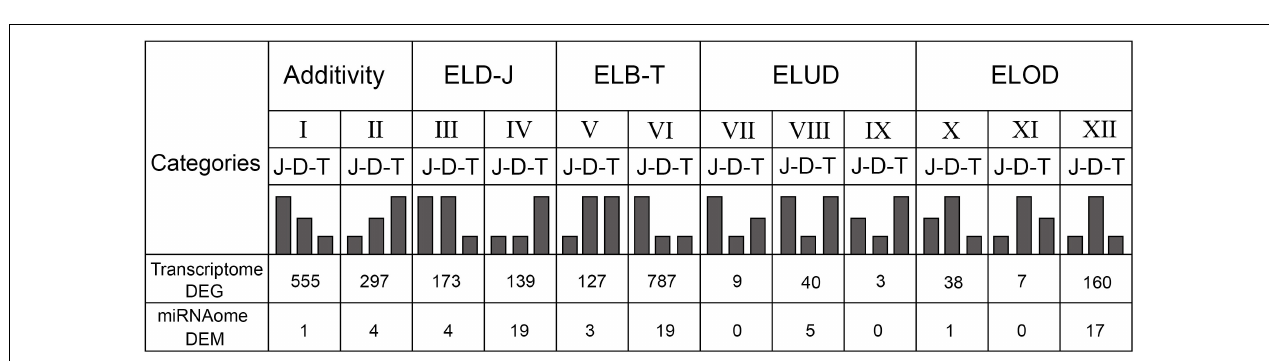
FIGURE 3 | KEGG pathway enrichment of the NEGs. This figure consists of the pathways, the second-class hierarchy, and the first-class hierarchy. The first-class hierarchy and second-class hierarchy rank from top to bottom according to the number of pathways included in the hierarchy. The pathways rank from top to bottom according to the enrichment significance of each pathway. Each bar represents the enrichment count of transcripts in a KEGG pathway. *EIP, environmental information processing; CP, cellular processes; GIP, genetic information processing.